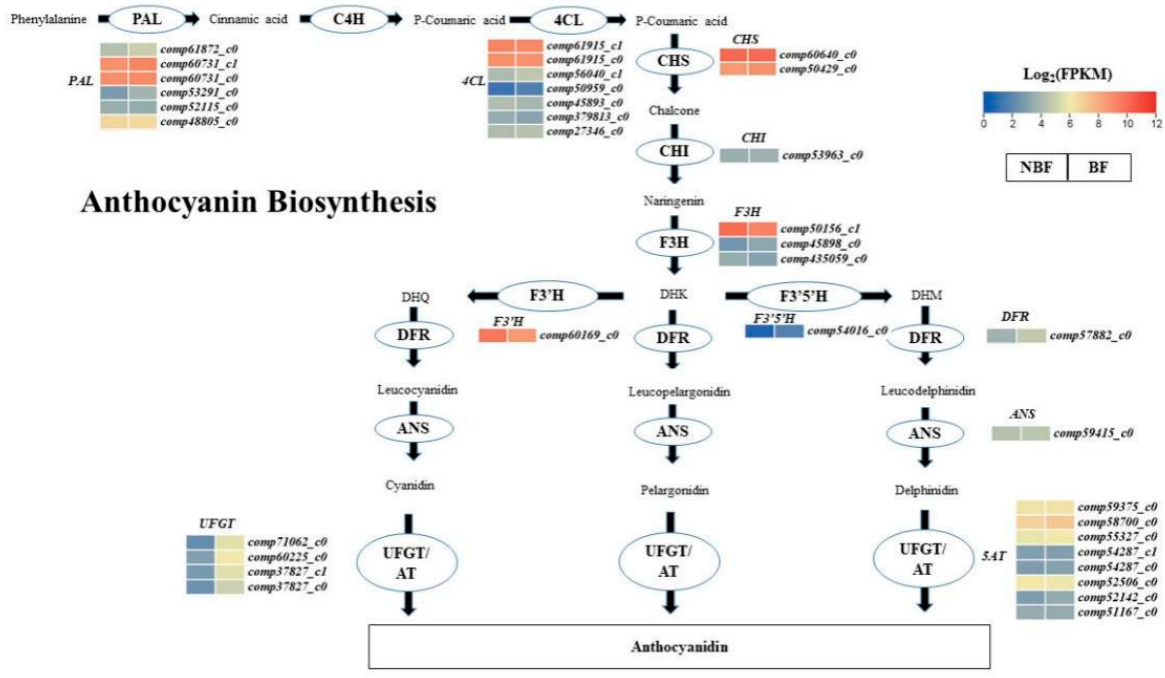
Figure 4. Anthocyanin biosynthesis pathway and synthetic gene expression in pansy. The expression levels of biosynthetic genes are shown in a range of color scores. PAL: Phenylalanine ammonia- lyase; C4H: Trans-cinnamate 4-monooxygenase; 4CL: 4-coumarate CoA ligase; CHS: Chalcone syn- thase; CHI: Chalcone isomerase; F3H: Flavanone-3 β -hydroxylase; F3 ′ H: Flavonoid-3 ′ -hydroxylase; DFR: Dihydroflavonol reductase; ANS: Anthocyanin synthase; UFGT: UDP-glucose flavonoid 3-